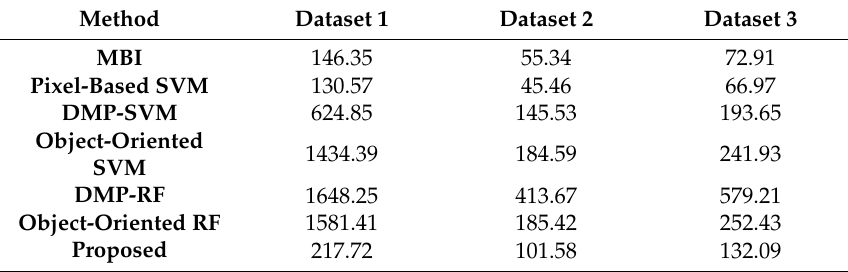
Table 6. Running time (second) of all building detection methods used in this